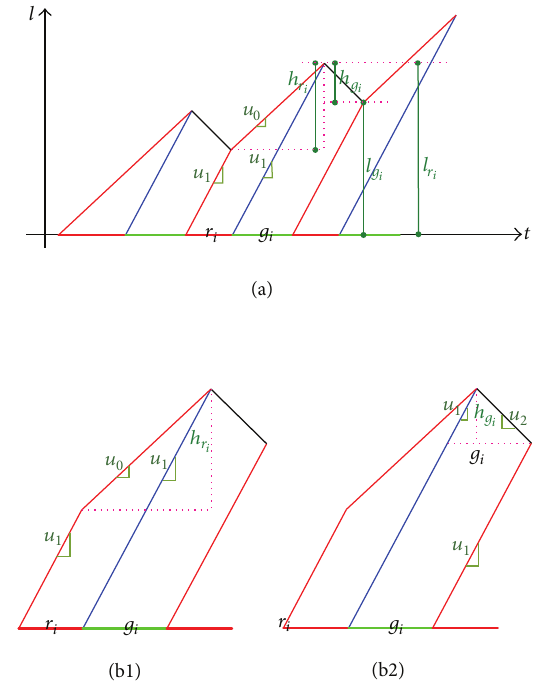
Figure 7: Stopping wave and starting wave with insufficient split.